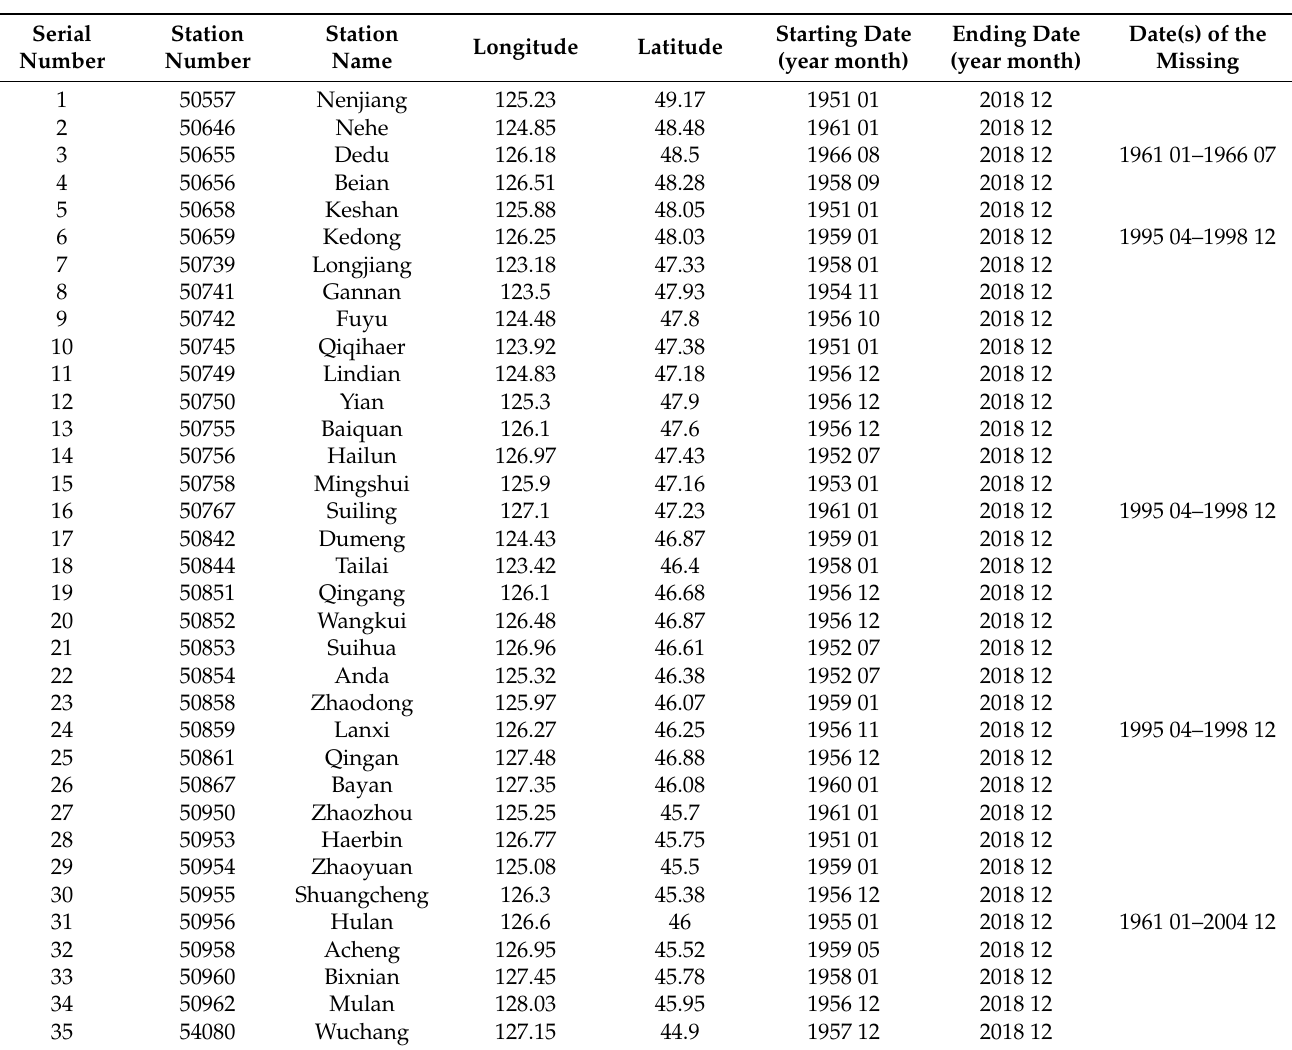
Table 1. Information on the meteorological sites on Songnen Plain in Heilongjiang